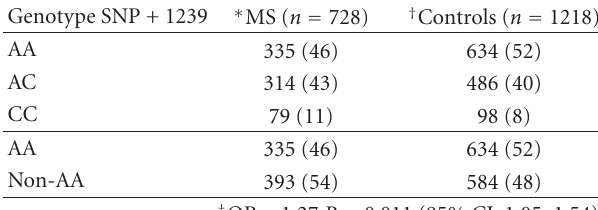
Table 1: Frequency distribution of OPN +1239A > C genotypes in MS patients and healthy controls.